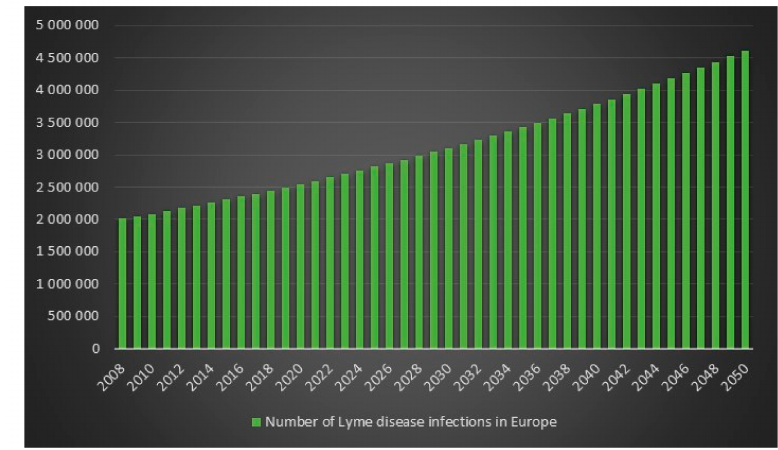
Figure 13. Number of Lyme disease infections in Europe between the years 2008 to